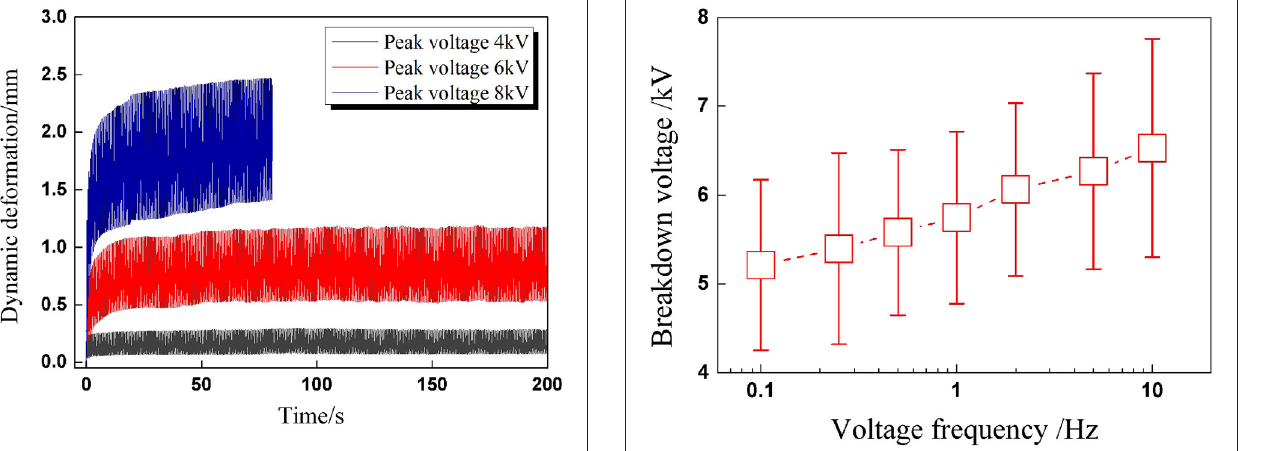
different frequencies.